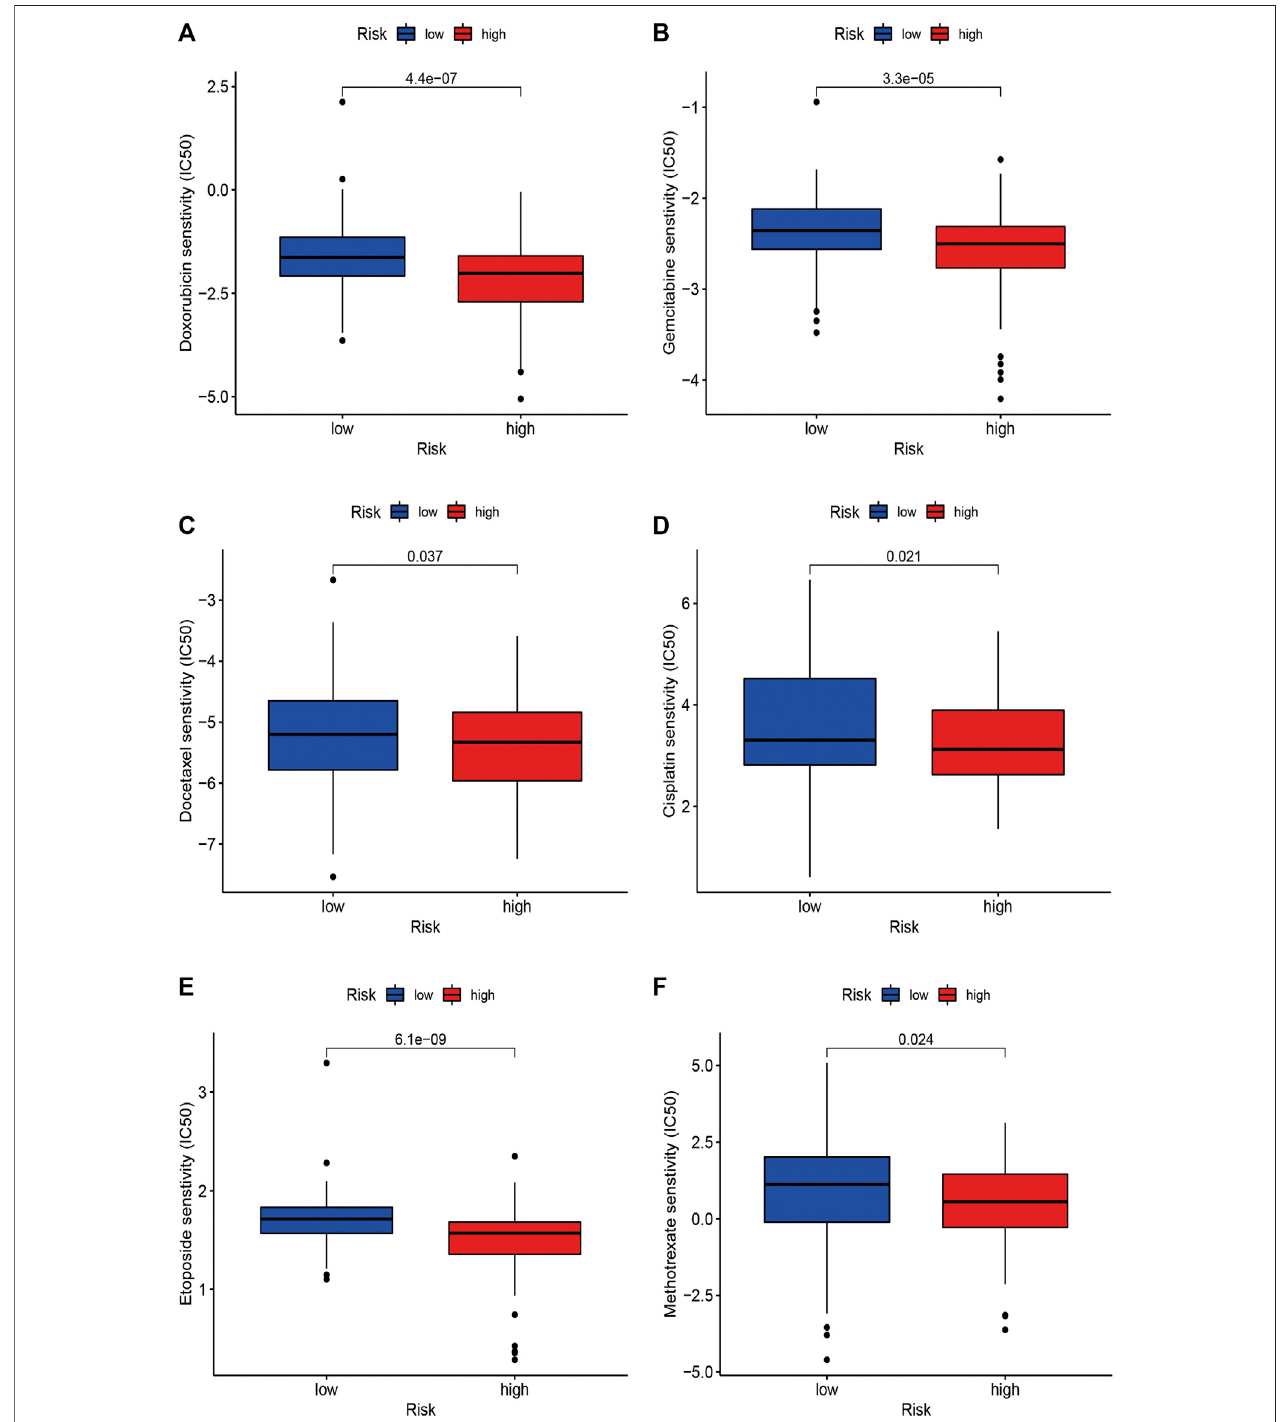
FIGURE11 | The correlations between the risksignature and chemosensitivity in STS. TheIC50 of (A) doxorubicin, (B) gemcitabine, (C) docetaxel, (D) etoposide, (E) cisplatin, and (F) methotrexate in the high-risk and low-risk groups.